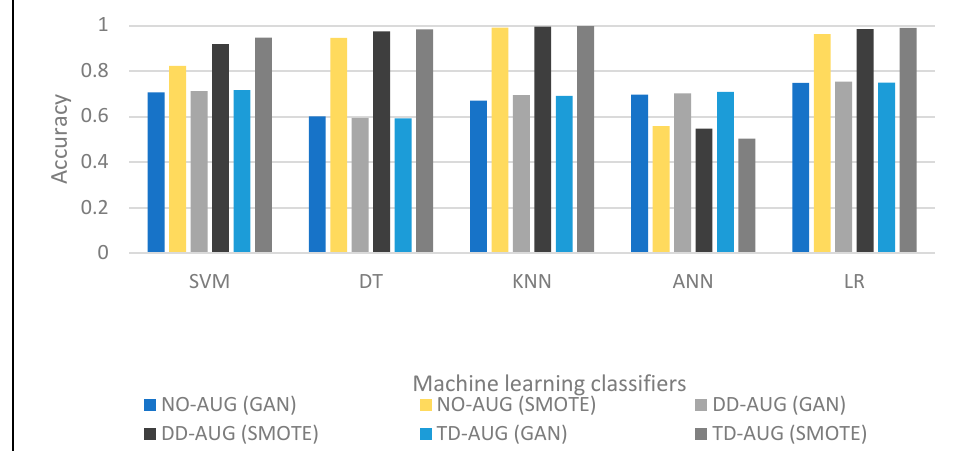
Figure 5. Performance comparison of different machine learning techniques.